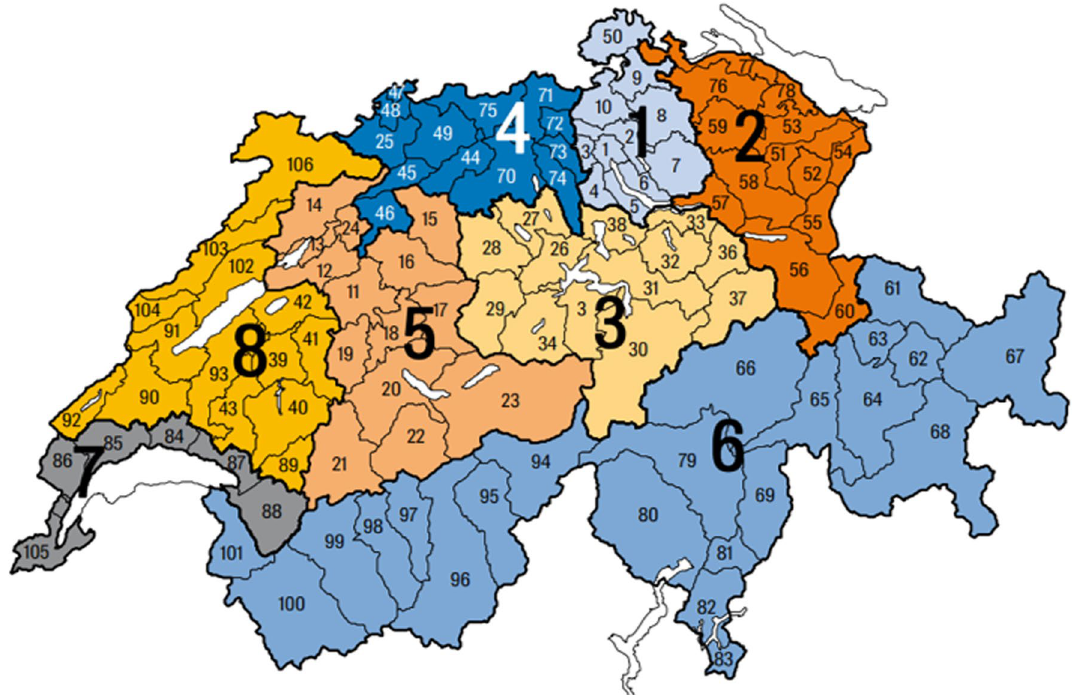
Fig. 1 MS-regions and monitoring regions of Switzerland. Notes : Monitoring regions according to Wüest Partner AG are shown in large letters: 1 Zurich, 2 East Switzerland, 3 Central Switzerland, 4 = = = MS-Regions according to the Federal Statistical Office (2005) are displayed in small letters. Source : Wüest Partner